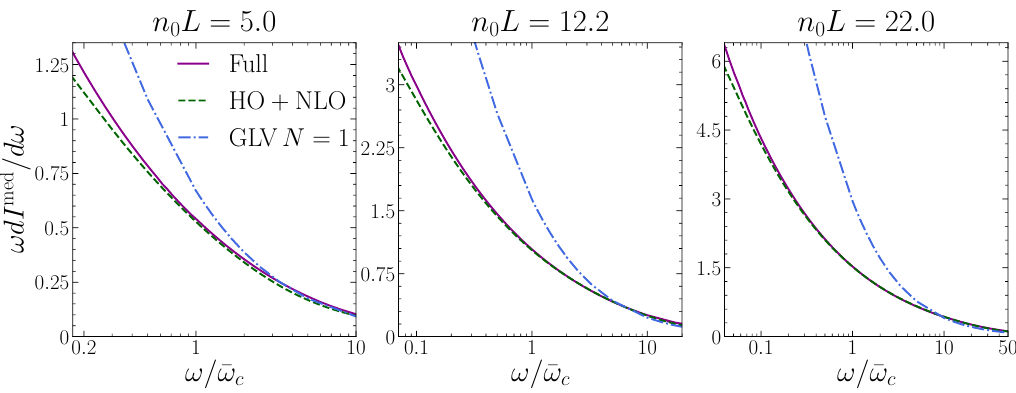
Figure 2: All-order (solid lines), IOE HO + NLO (dashed), and GLV N = 1 (dash- dotted) medium-induced gluon energy spectra for a Yukawa parton-medium inter- = 2 ω/µ 2 L for different values of n L . Figure extracted action as a function of ω/ ¯ ω c 0 from [ 1 ] under Creative Commons Attribution License (CC BY